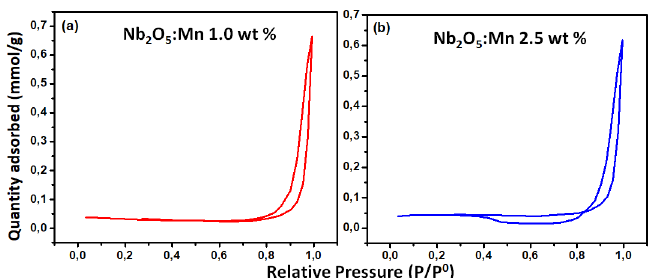
Figure 4. Adsorption isotherms of Mn-doped Nb 2 O 5 ( a ) 1.0 and ( b ) 2.5 wt.% samples, annealing at 700 ◦ C.